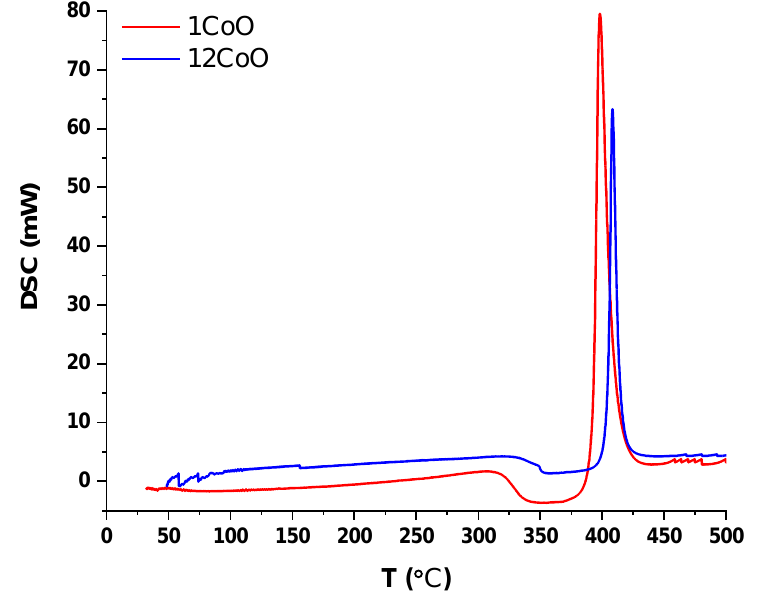
Figure 8. DSC curves for the explored glasses with various CoO concentrations.